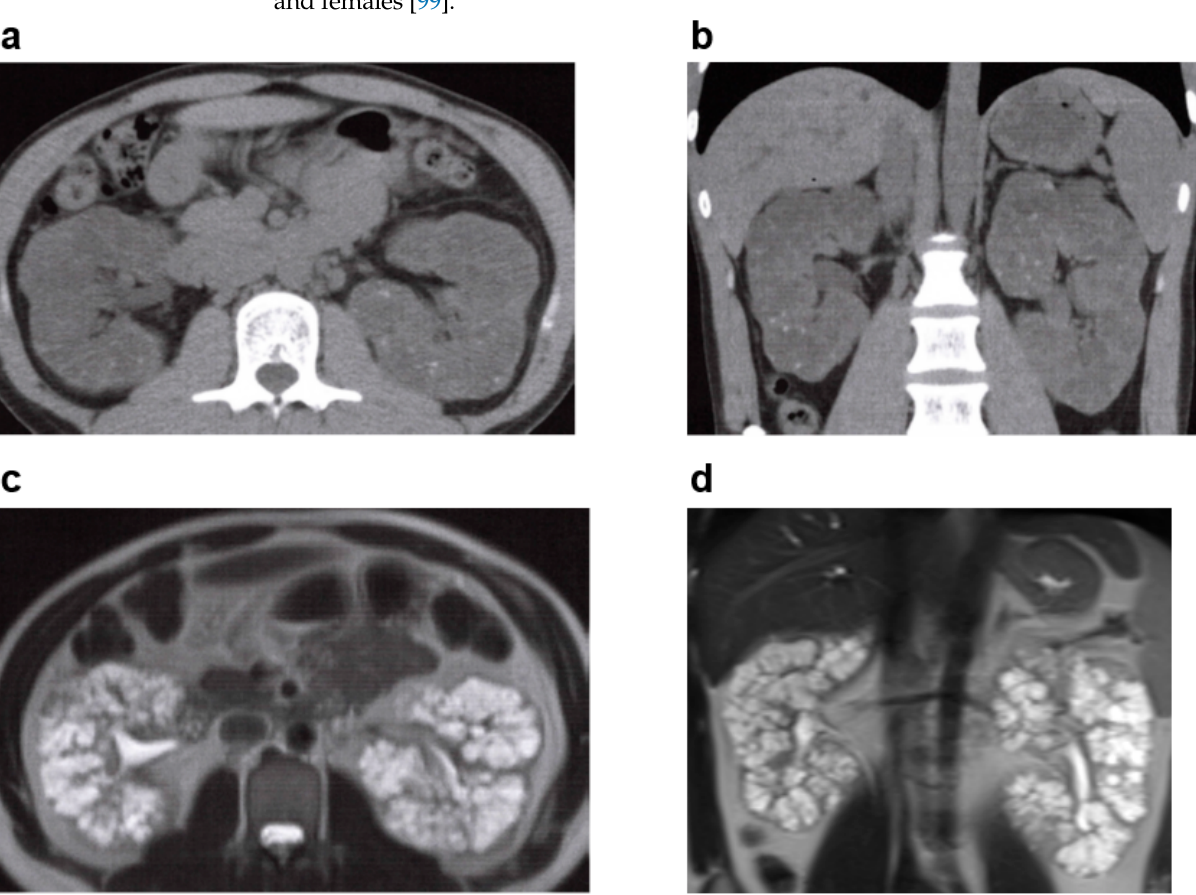
Figure 9. Nephronophthisis (NPH): 20s, male, NPHP4 gene compound heterozygous mutation, no family history of polycystic kidney disease or end-stage kidney disease, no history of cerebral aneurysm or heart valve disease, kidney function eGFR 29.4 mL/min/1.73 m 2 (image provided by Toranomon Hospital). ( a ) Non-contrast CT image (horizontal section): multiple low-density regions in both kidneys. ( b ) Non-contrast CT image (coronal section): multiple low-absorbance regions in both kidneys. ( c ) MRI T2-weighted image (horizontal section): multiple hyperintense cyst-like lesions in both kidneys. ( d ) MRI T2-weighted image (coronal section): multiple hyperintense cyst-like lesions in both kidneys.